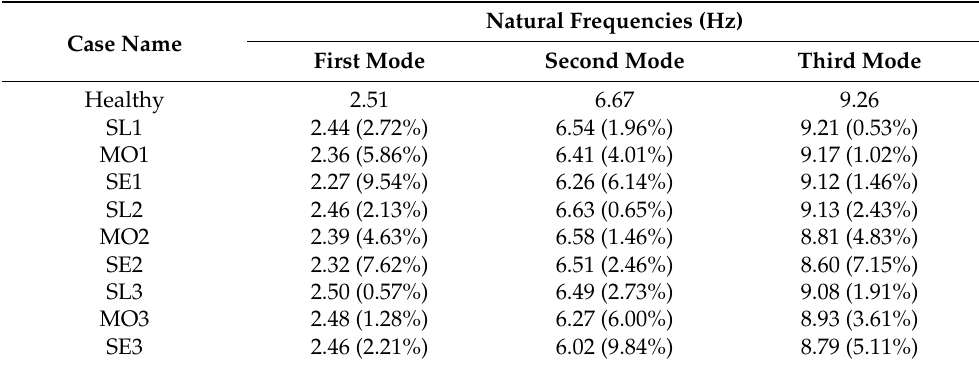
Table 3. Natural frequencies of ten simulation